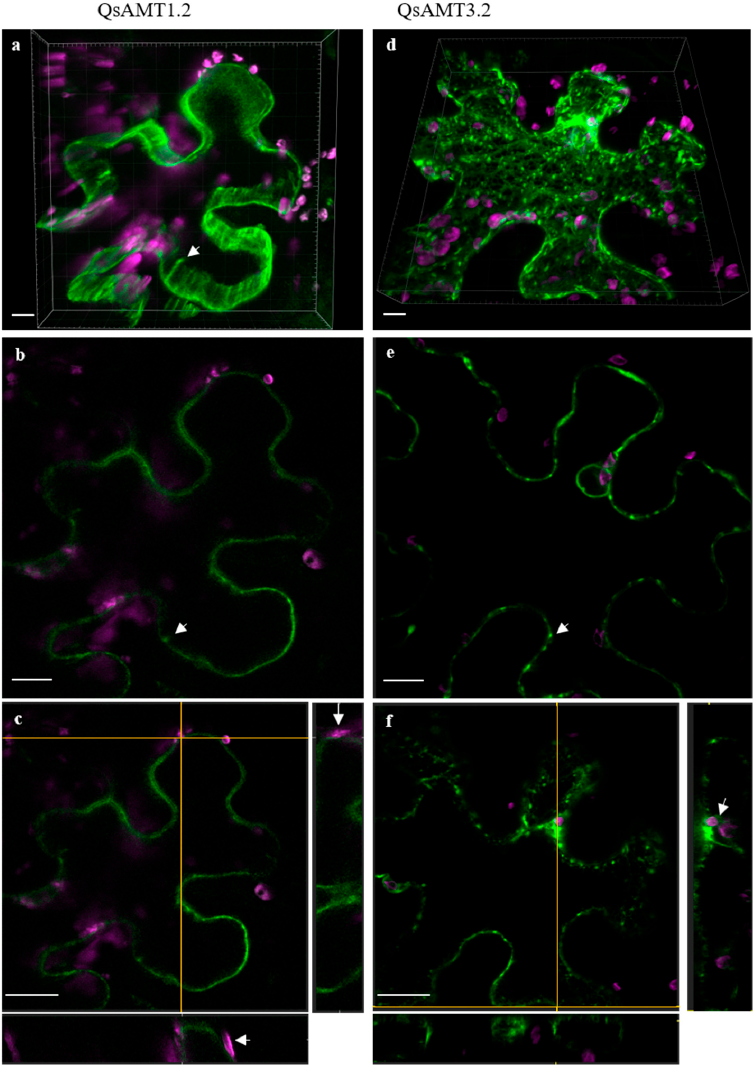
Figure 4. Cellular localization of QsAMT 1.2 and QsAMT3.2. ( a ) The 3D maximal intensity